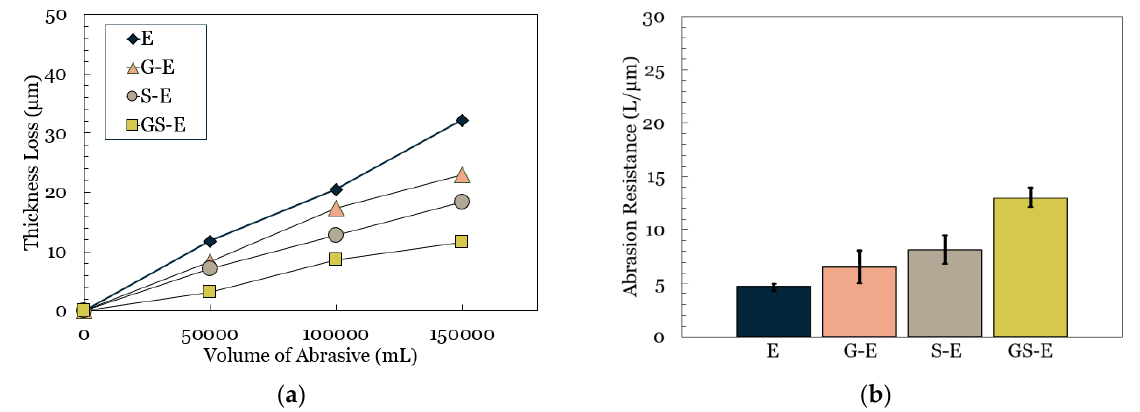
Figure 12. Summary of abrasion resistance test results: ( a ) thickness loss and ( b ) abrasion resistance of coated rebars.